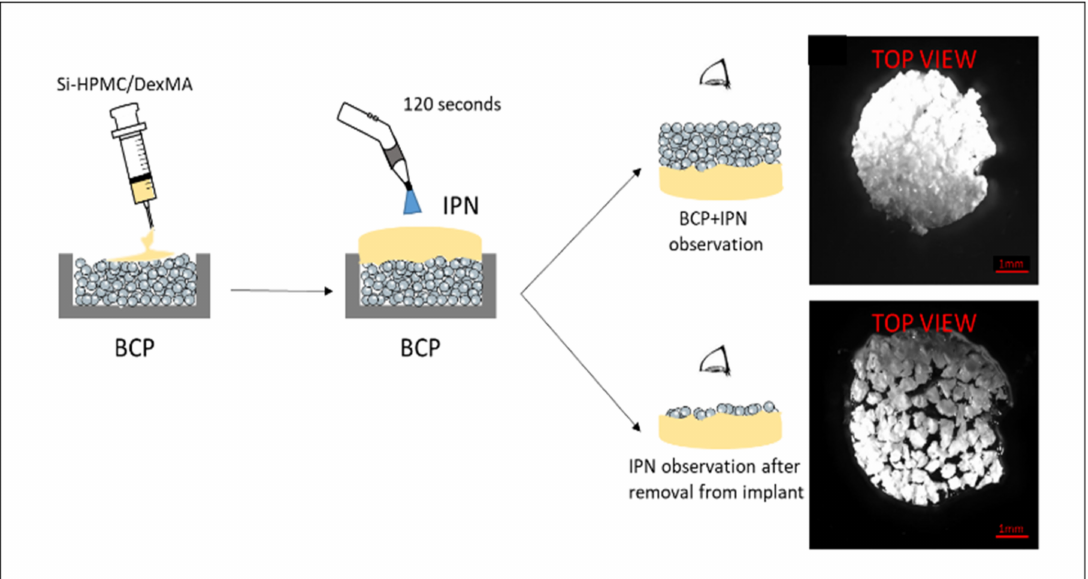
Figure 4. Schematic outline of the preparation of an implant composed of BCP and IPN hydrogel membrane. The cylindrical mold was filled with BCP. Si-HPMC/DexMA solution was injected onto the BCP surface. The solution was photo-crosslinked for 120 s with visible light from a lamp to form the IPN. BCP with IPN and IPN after removal from the BCP were observed with a microscope. Mold with an 8 mm diameter and a 1.5 mm height. Si-HPMC: silanized hydroxypropyl methylcellulose, DexMA: dextran methacrylate, Si-HPMC/DexMA: silanized hydroxypropyl methylcellulose/dextran methacrylate, BCP: biphasic calcium phosphate, IPN: interpenetrating polymer